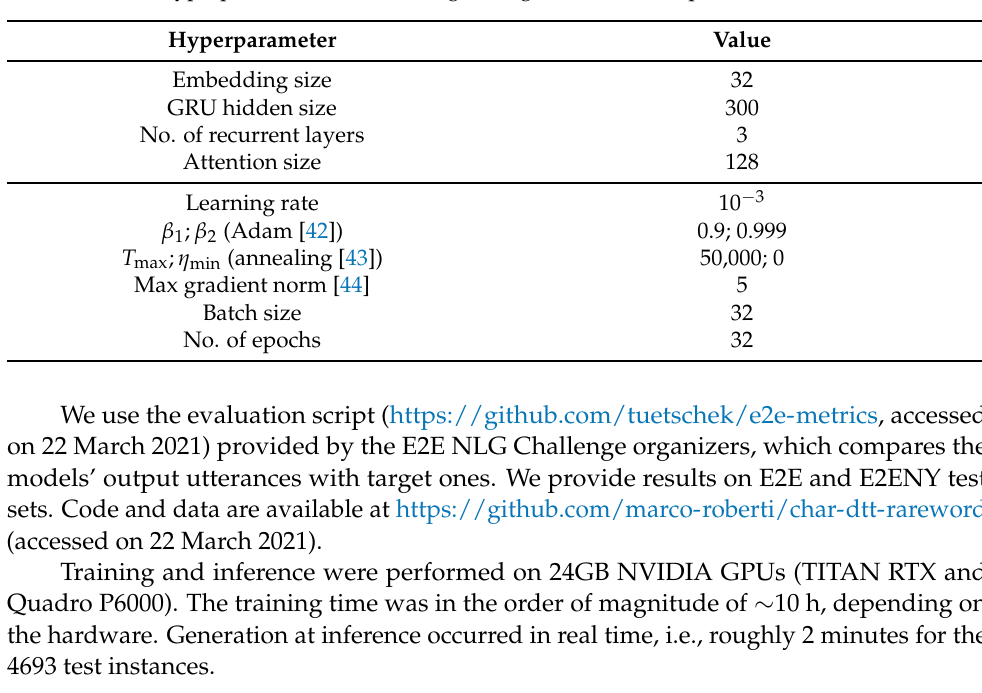
Table 2. Model hyperparameters and training settings used in our experiments.